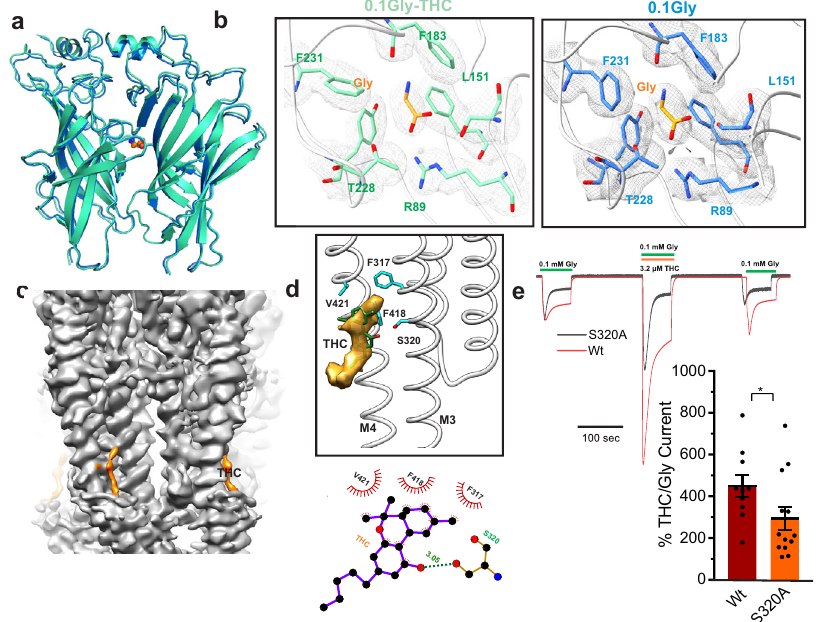
Fig. 2 | THC modulation of GlyR gating. a Alignment of GlyR-0.1gly and GlyR- 0.1gly-THC structures. A side-view of the ECD-ECD subunit interface in the two structures. b Cryo-EM density segments for the neurotransmitter-binding site residues(gray)andtheboundglycinemolecule. c Cryo-EMmapofGlyR-0.1gly-THC with THC density highlighted in orange. d THC molecule within the intrasubunit grooveformedbytheM3andM4helices (top) .LigPlotanalysis 96 ofTHCinteraction withthebindingpocket.Residueswithin4Ådistancearedisplayedinred (bottom) . e ContinuousTEVCrecordingsofWTGlyR and S320Aactivatedby0.1mMglycine,